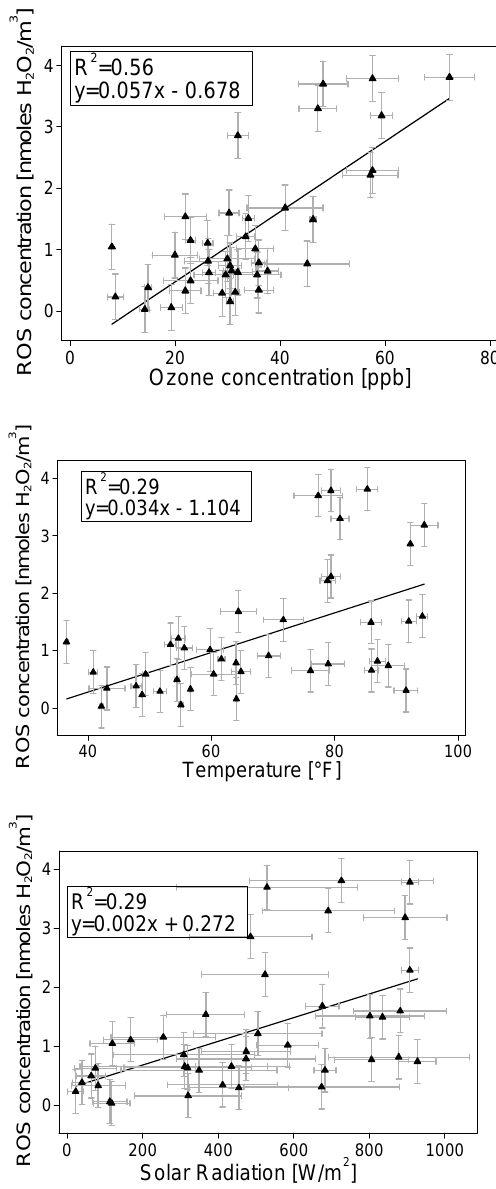
Figure 2: Linear regression graphs showing significant relationships between particulate ROS concentrations and O 3 concentration, temperature, and solar radiation. Error bars for ROS concentration represent the average standard error of replicate ROS samples. Error bars for environmental conditions represent the variance in the measurements during the 3h sampling period.